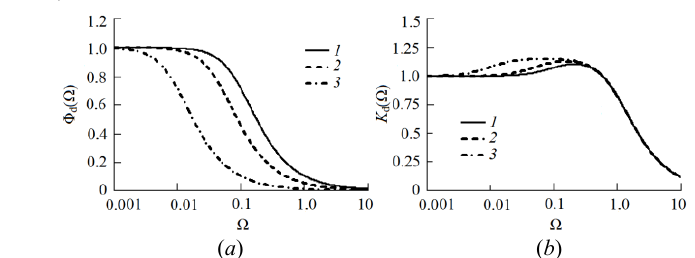
Fig. 1. Diagrams AFC